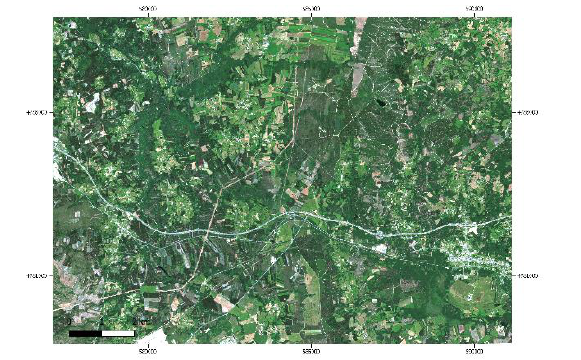
Figure 3. Worldview-2 image in RGB composition (5,3,2).